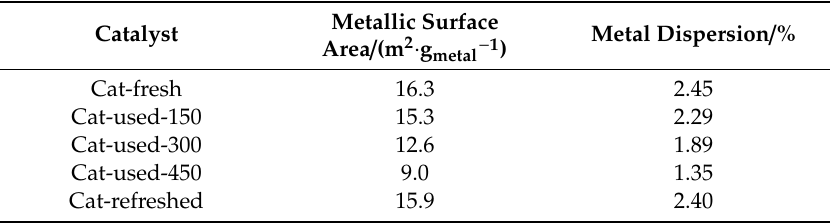
Table 3. Metallic surface area and metal dispersion of